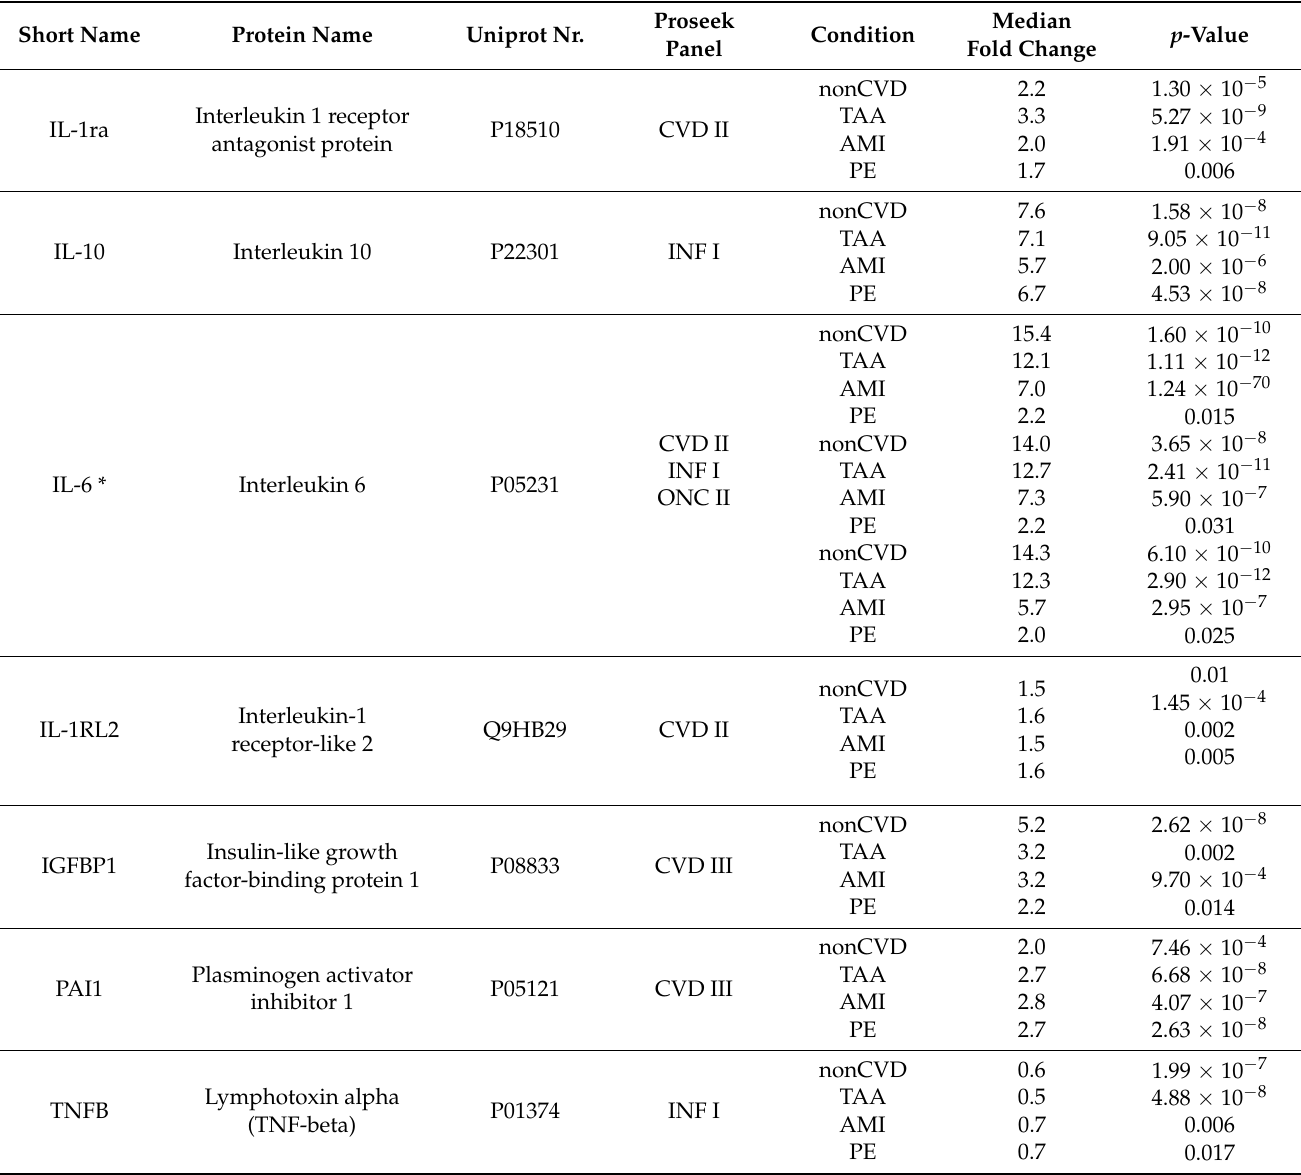
Table 3. List of OLINK Proseek ® Multiplex biomarkers that showed significant difference in the AAD group in comparison to all other analyzed